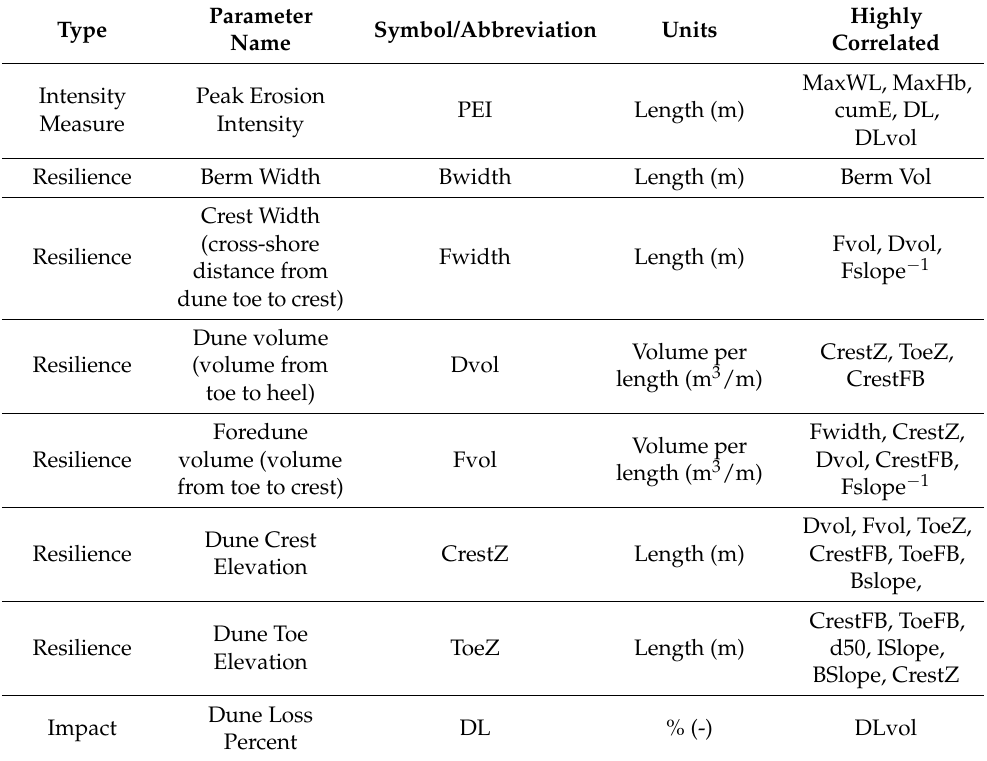
Table 4. Reduced parameters of interest. Note FB denotes freeboard or vertical distance between parameter and mean sea level, WL—water level, vol—volume, Hb—breaking wave height, cumE— cumulative energy (H 2 ), Z denotes elevation, Max denotes the maximum hourly value over a single storm duration and Bslope/Islope denote beach and intertidal slope.